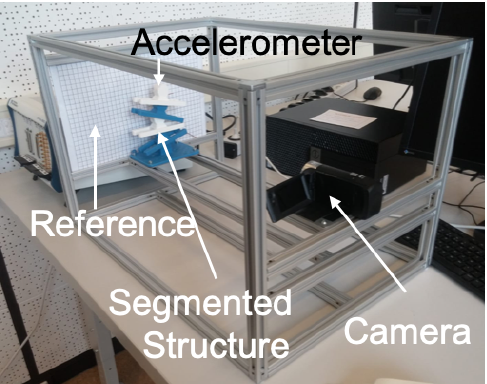
Figure 10. The musculoskeletal system and the video camera were secured to a rigid test frame to maintain accurate measurements. A scale reference was positioned behind the system to facilitate reference for the tracking